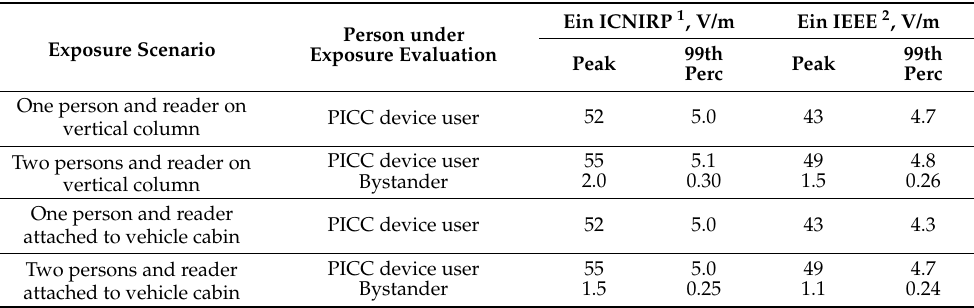
Table 4. Ein (internal/in situ electric field) values in the human body models in various exposure scenarios related to exposure to EMF at 13.56 MHz near to the HF RFID reader with an internal antenna with inner dimensions of 8 × 8 cm, assuming that the RR of considered reader is 10 cm (according to ISO/IEC 14443-2:2020 requirements for PICCs of classes